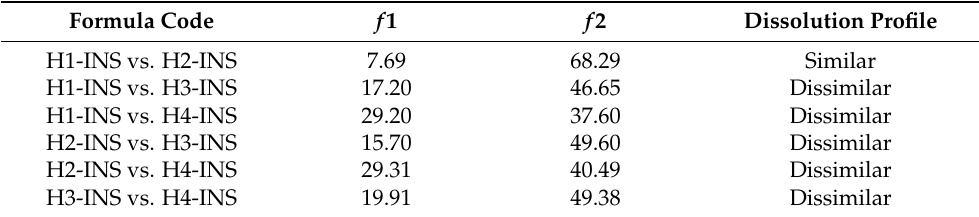
Table 3. Pairwise comparison of the similarity factors f 1 and f 2 of the drug release profiles. Formula